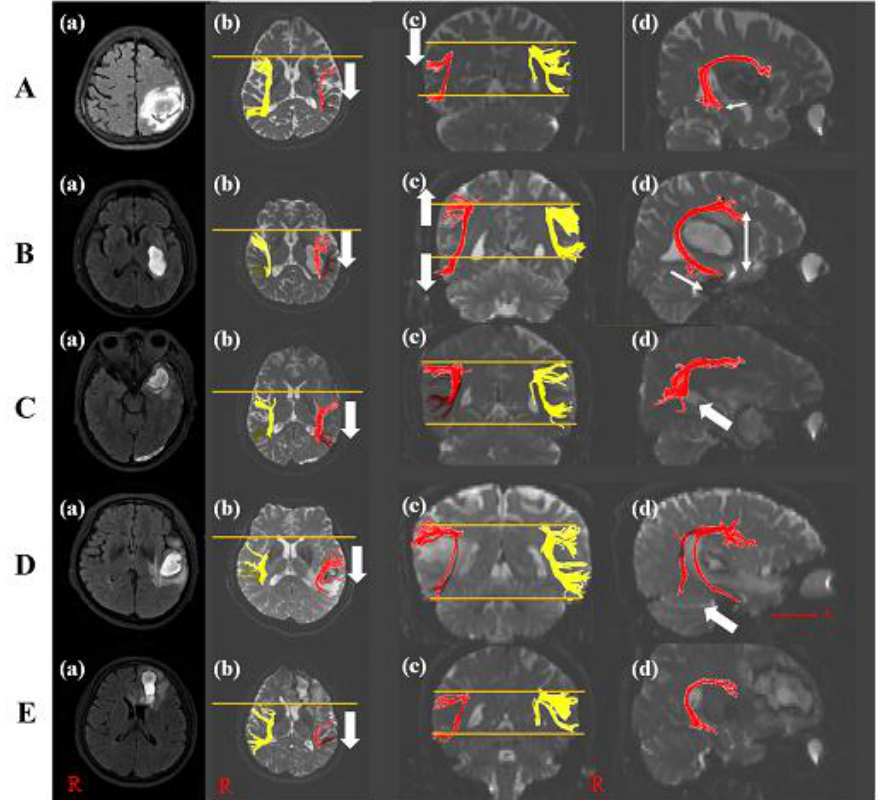
Figure 2. Di ff usion tensor image of five patients. ( A ) T2-weighted MRI of patient 1 with the left parietal lobe ICH ( a ). The posterior shift ( b ) and down shift ( c ) of the left AF compared with the right AF was shown (white arrow). The disruption of Wernicke’s territory of the left AF appeared compared with that of control subject (( d ), white arrow). ( B ) T2-weighted MRI of patient 2 with the left basal ganglia ICH ( a ). The posterior shift ( b ) and wide width ( c ) of the left AF compared with the right AF was shown (white arrow). The longer length of Wernicke’s territory of the left AF appeared than that of control subject (( d ), white arrow). ( C ) T2-weighted MRI of patient 3 with the left anterior temporal lobe ICH ( a ). The posterior shift ( b ) and the disruption of Wernicke’s territory of the left AF appeared compared with that of control subject (( d ), white arrow) without the di ff erence in the structure compared with the right AF ( c ). ( D ) T2-weighted MRI of patient 4 with the left temporal lobe ICH ( a ). The posterior shift (b) and a few tracts of Wernicke’s territory of the left AF appeared compared with that of control subject (( d ), white arrow) without the di ff erence compared with the right AF ( c ). ( E ) T2-weighted MRI of patient 5 with the left frontal lobe ICH ( a ). Broca’s territory was shifted posteriorly ( b ) and showed thinner tracts compared with controls without the change of Wernicke’s territory (( c , d )). Note: MRI, magnetic resonance image; AF, arcuate fasciculus; ICH, intracranial hemorrhage; R, right; A, anterior.